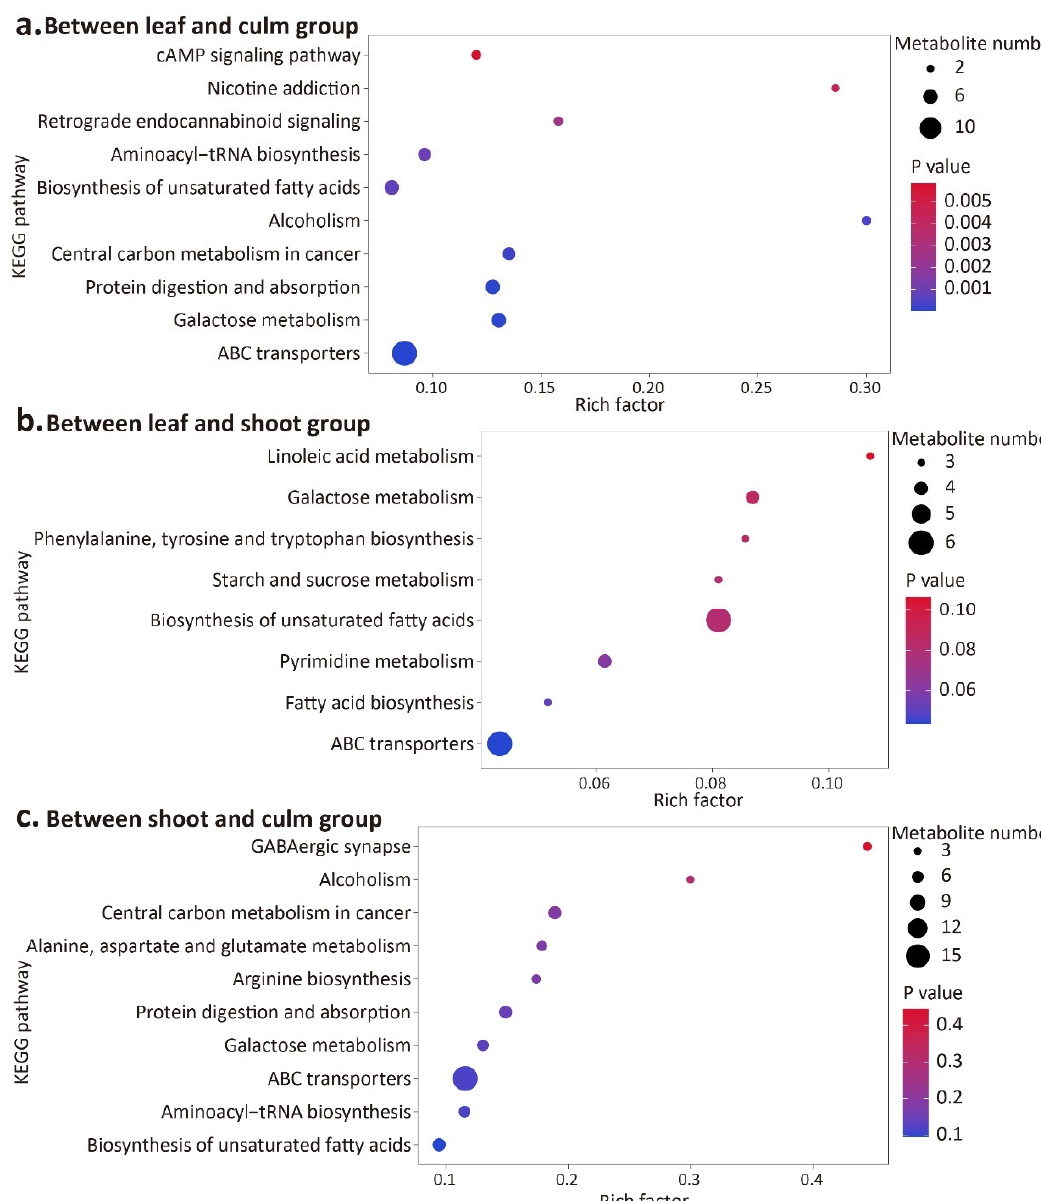
Figure 2. KEGG enrichment analysis bubble map showed that the top 10 metabolic pathways enriched by significant differential metabolites between ( a ) leaf and culm group, ( b ) leaf and shoot group, and ( c ) shoot and culm group. The rich factor is the ratio of the number of signi fi cantly different metabolites detected to the number of metabolites annotated in the pathway, with higher rich factor values representing higher levels of enrichment. The size of the point represents the amount of enrichment of signi fi cant metabolites in the corresponding metabolic pathway.